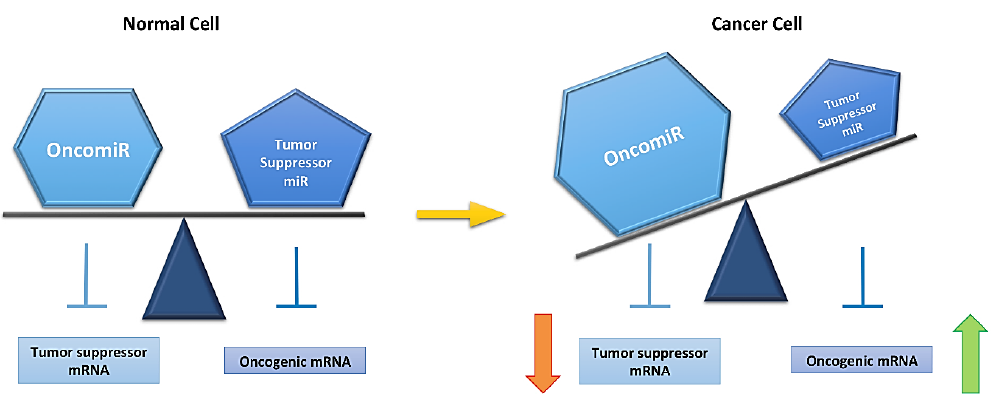
Figure 2. MicroRNA (miR) expression is altered in a cancer cell. A normal cell has equilibrium between oncomiRs (overexpressed miRs in cancer) and tumor suppressor miRs (downregulated miRs in cancer), This equibrium is lost in a cancer cells (yellow arrow). This is reflected on mRNA expression, rising oncogenic and decreasing tumor suppressor mRNA levels, and allowing for cancer development.